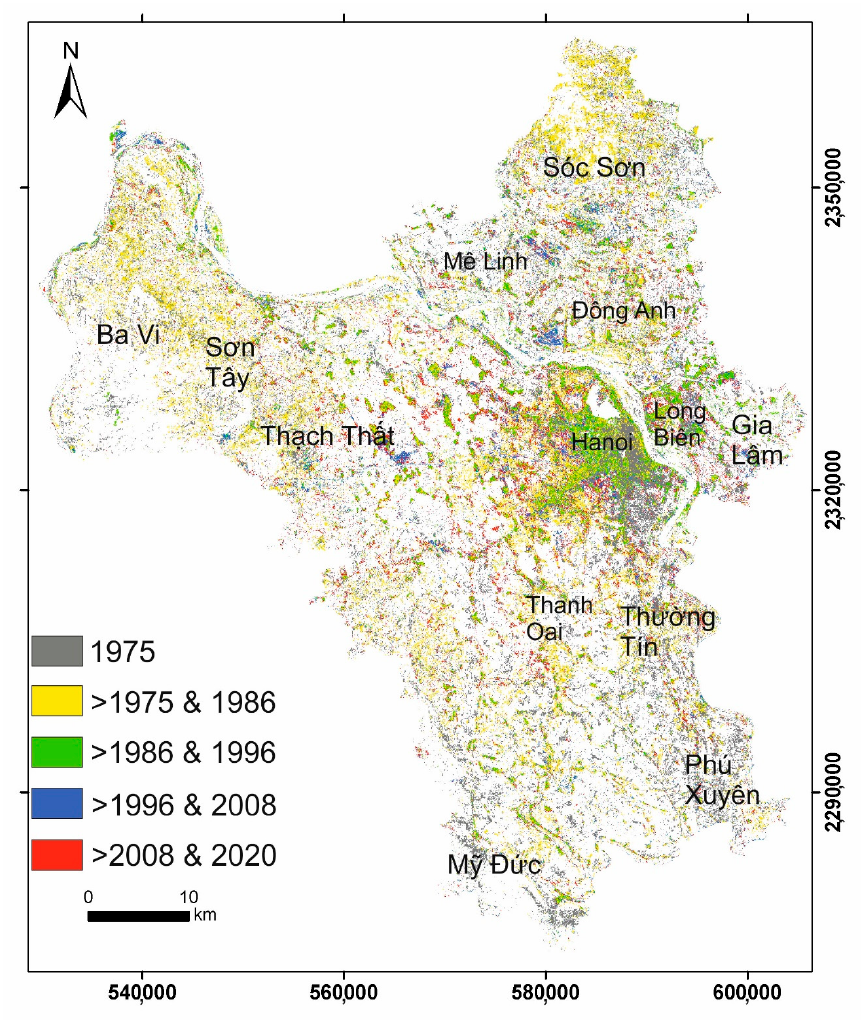
Figure 3. Expansion of the artificial surfaces areawithin the Hanoi Province across five decades. Starting from 1975, each colour corresponds to the extension of artificial surfaces at the end of each decade, approximatively. Coordinate system: WGS1984, UTM Zone